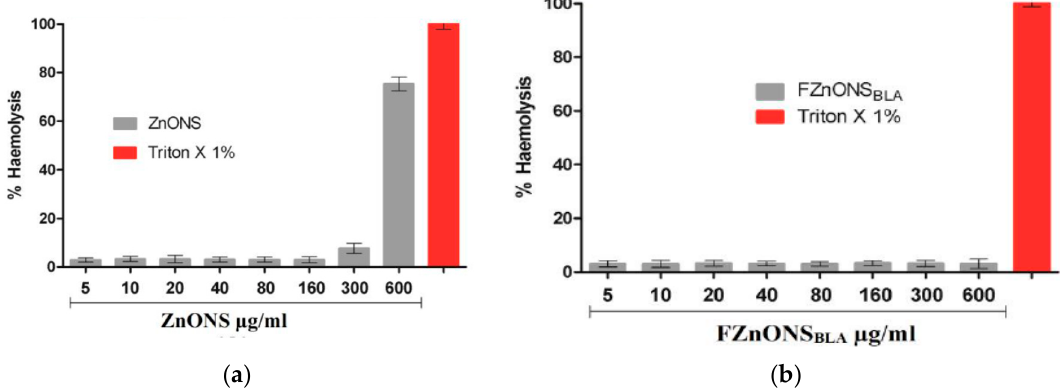
Figure 46. Hemocompatibility assay results of human erythrocytes treated with ( a ) ZnO nanostrucuture (ZnONS) and ( b ) bovine α -lactalbumin (BLA) functionalized ZnONS of different concentrations. Trixton X 1% was employed as a control. All the data were expressed as mean ± standard deviation, n = 3. Reproduced from [326] with permission of